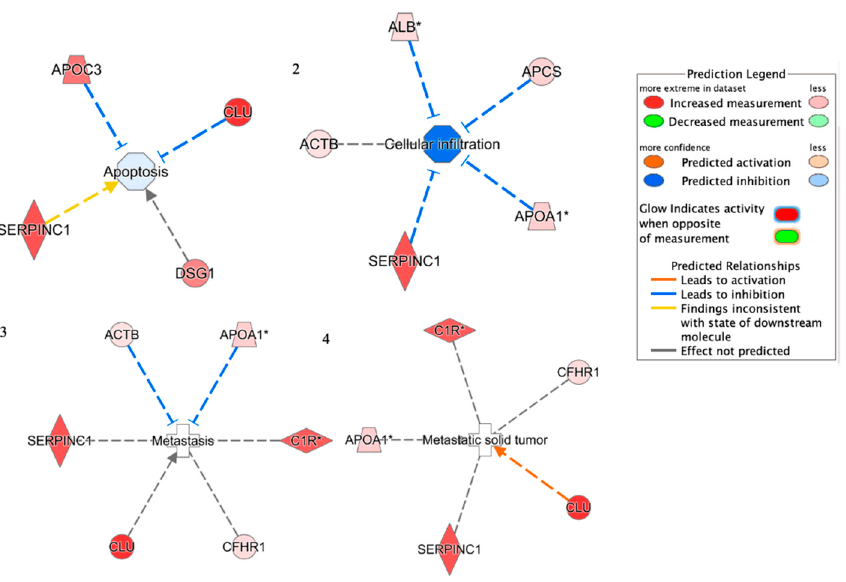
Figure 7. Network build-up from one of the most significant bio-functions: ( 1 ) Apoptosis; ( 2 ) Cellular infiltration; ( 3 ) Metastasis; ( 4 ) Metastatic solid tumor.